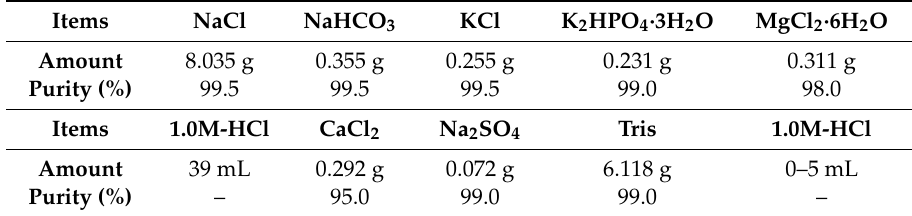
Table 2. Composition of SBF (1000 mL) used in the apatite mineralization